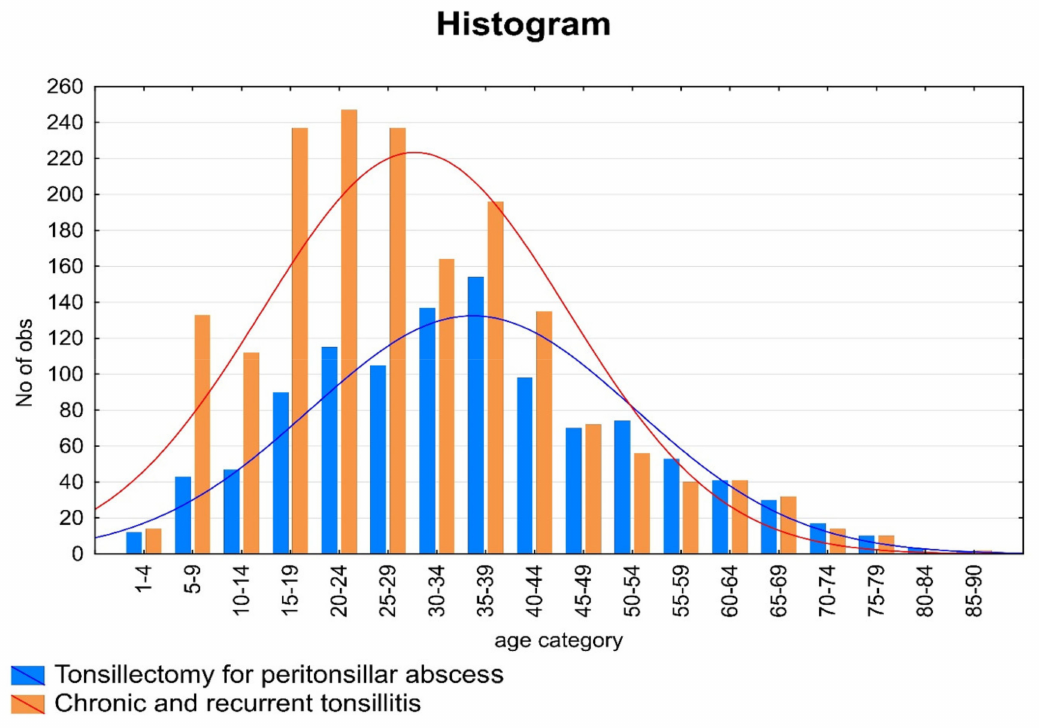
Figure 2. The age distribution of patients in both groups.